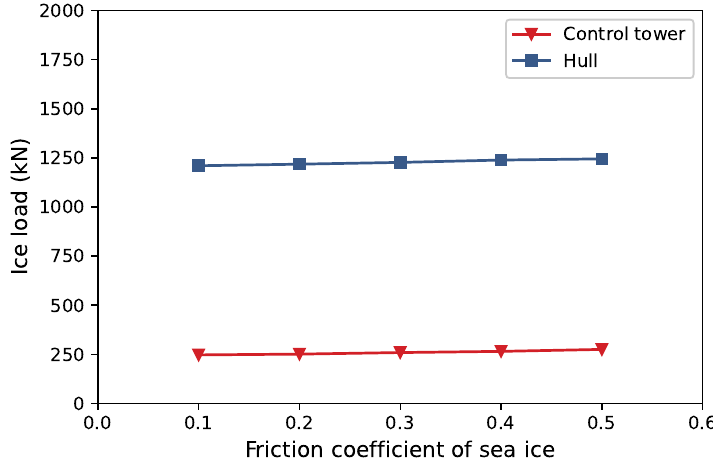
Figure 12. The relation curve between submarine ice load and sea ice friction